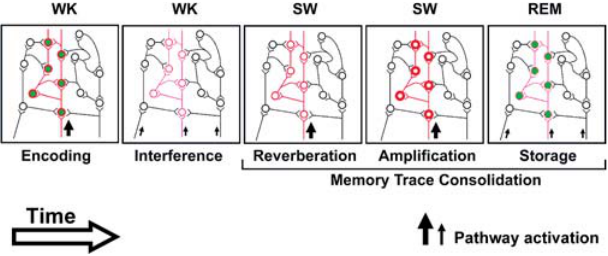
Figure 6. Conceptual Model of the Role of Sleep for Memory Consolidation Arrows indicate pathway activation by sensory inputs during WK, as well as intrinsic brain activity such as pontine waves during sleep (Datta 2000); different arrow sizes indicate different magnitudes of pathway activation. Red indicates calcium-dependent pretranscrip- tional processes, with different hue intensities representing the progressive amplification of recently acquired synaptic changes. Green indicates plasticity-related transcriptional regulation. The initial state of the model (data not shown) consists of environmental habituation, during which ongoing activity patterns only repeat themselves by chance. (First panel) A novel WK experience encodes a memory trace across multiple forebrain areas, selectively activating functionally related synapses. This triggers calcium-dependent pretranscriptional cas- cades (red) and plasticity-related gene expression (green) that lead to the common strengthening of the activated synapses. (Second panel) The continuation of WK involves a succession of unrelated sensory experiences capable of producing interference, i.e., a progressive weakening of recently encoded synaptic changes. (Third panel) Upon entering SW sleep, intrinsic brain activation is biased towards previously potentiated synapses, causing neuronal firing patterns originally produced during the novel WK experience to reverberate significantly above chance levels. (Fourth panel) The periodic activation of calcium-dependent second- messenger cascades by large-amplitude SW oscillations may result in the progressive amplification of the synaptic changes that encode the novel memory trace. (Fifth panel) SW-amplified synaptic changes are stored during REM sleep by way of plasticity-related transcriptional regulation. DOI: